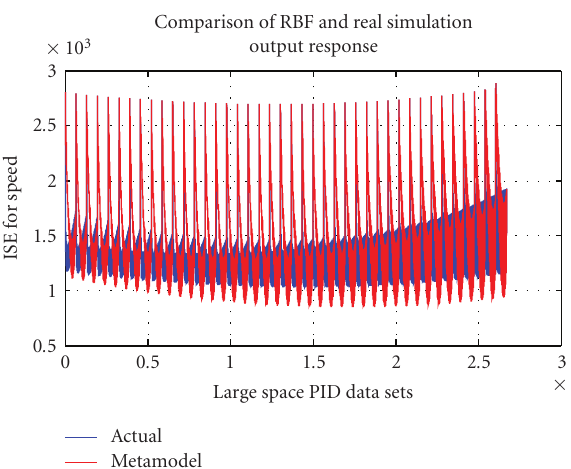
Figure 5: Comparison of metamodel and actual simulation output for nonlinear model.